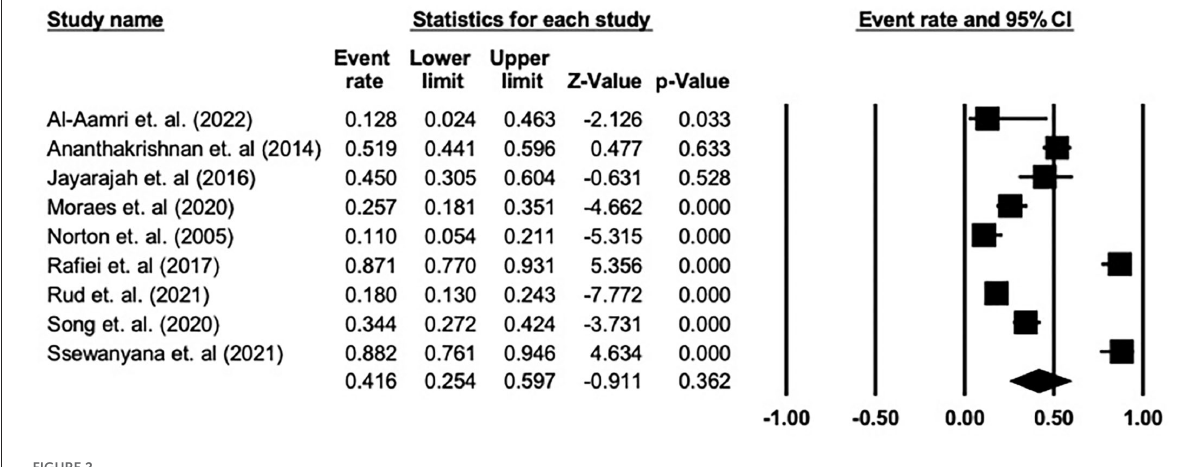
FIGURE2 Summary plot for the quality assessment of included studies.